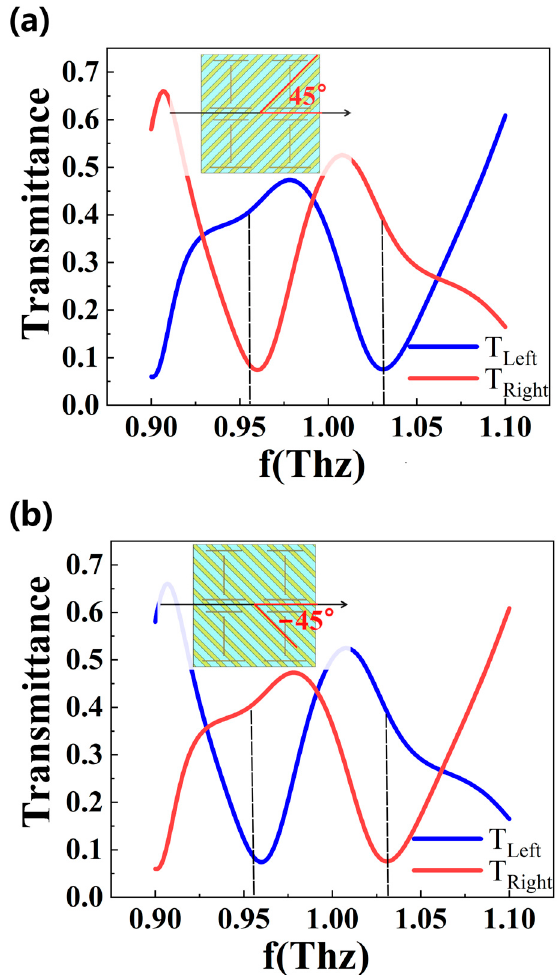
Figure 10. Correspondence between transmittance and frequency of circularly polarized detection structures. ( a ) The angle of the wire grating to the X-axis to 45°. ( b ) The angle of the wire grating to the X-axis to − 45°.